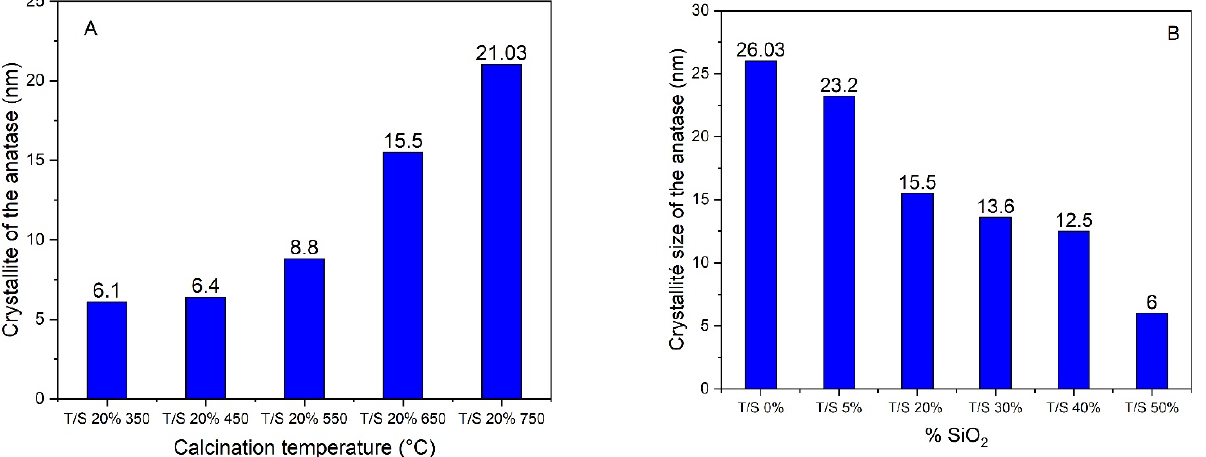
Figure 3. Anatase crystallite sizes of samples ( A ): T/S 20%–T (T = Temperature); ( B ): T/S–X (X= wt% SiO 2 ) calcined at 650 °C.